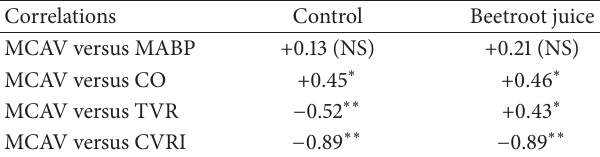
MCAV versus CVRI − 0.89